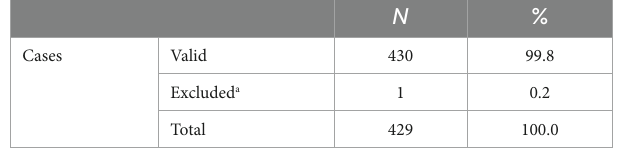
TABLE 2 Case processing summary.